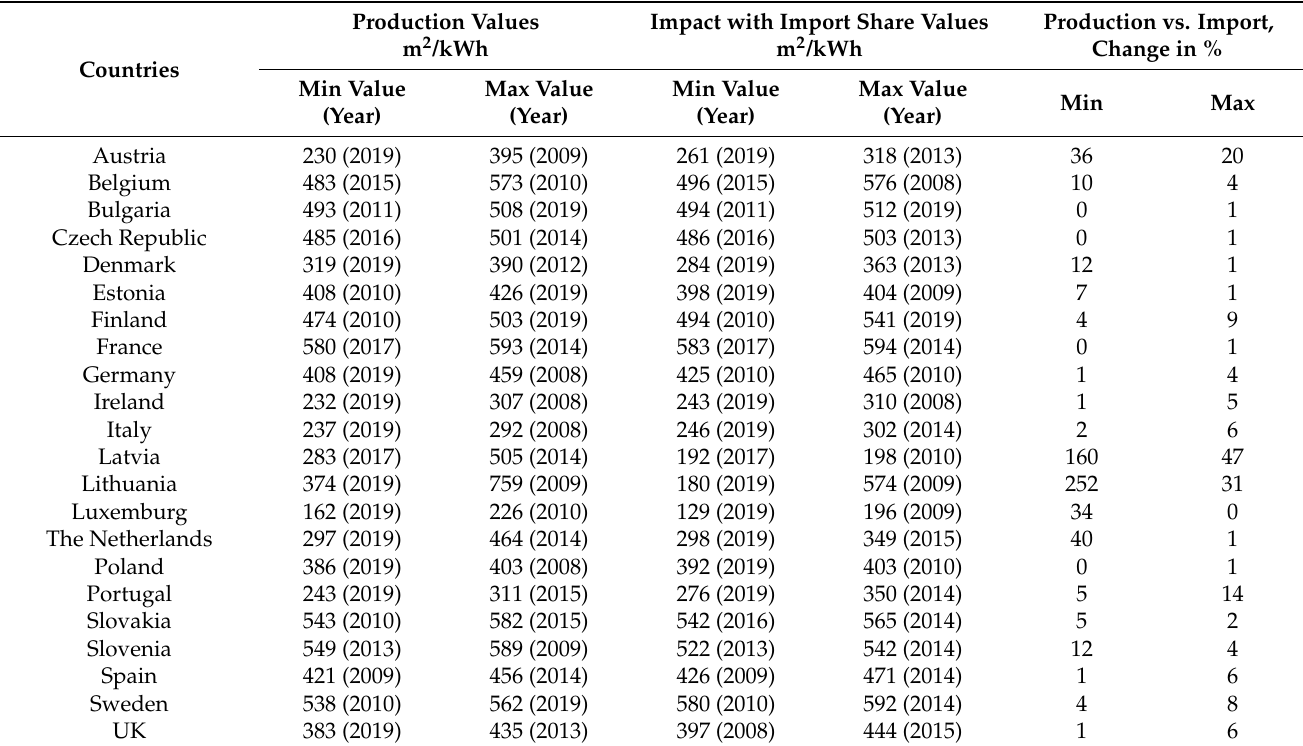
Table 5. Variation in the EF values for electricity production and electricity net mix in EU